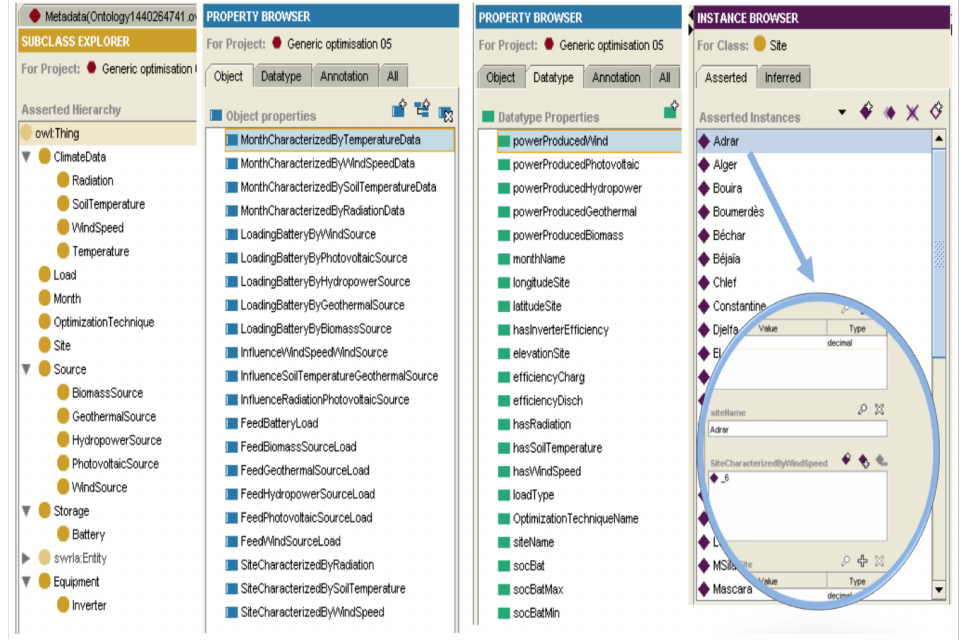
Figure 3. Elements of ontology in Prot é g é -OWL